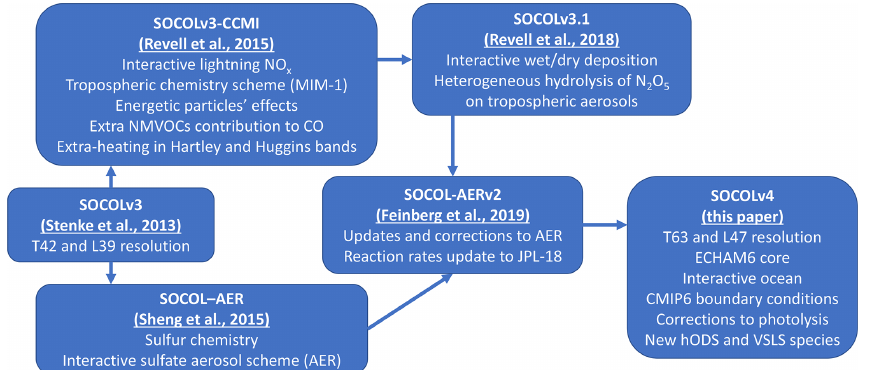
Figure 2. History of main updates through different versions of SOCOL, which contributed to the version described in this paper. Note that there were also other minor changes, adjustments, and error